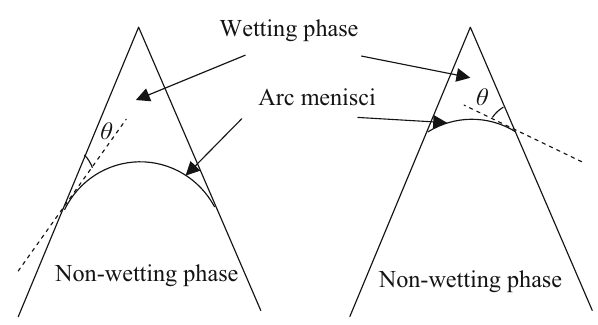
Fig. 7 Profile of corner menisci with different contact angles,